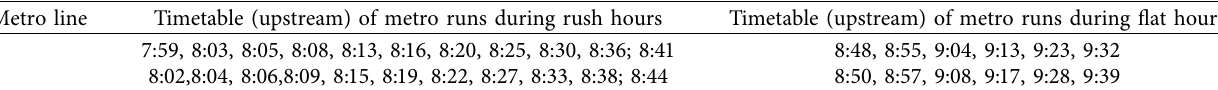
Table 1: The timetable (upstream) of metro runs during rush and flat hours in the Museum of Heilongjiang Province station. Metro line Timetable (upstream) of metro runs during rush hours Timetable (upstream) of metro runs during flat hours